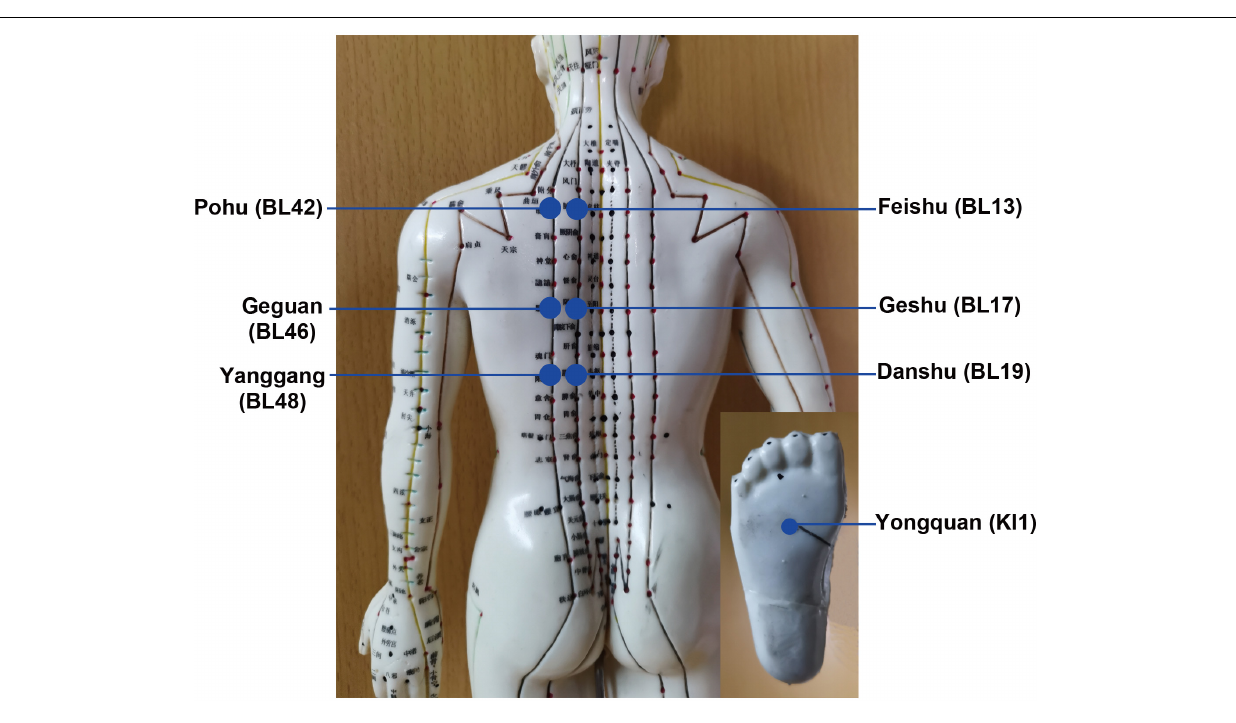
FIGURE 5 | Moxibustion acupoints and